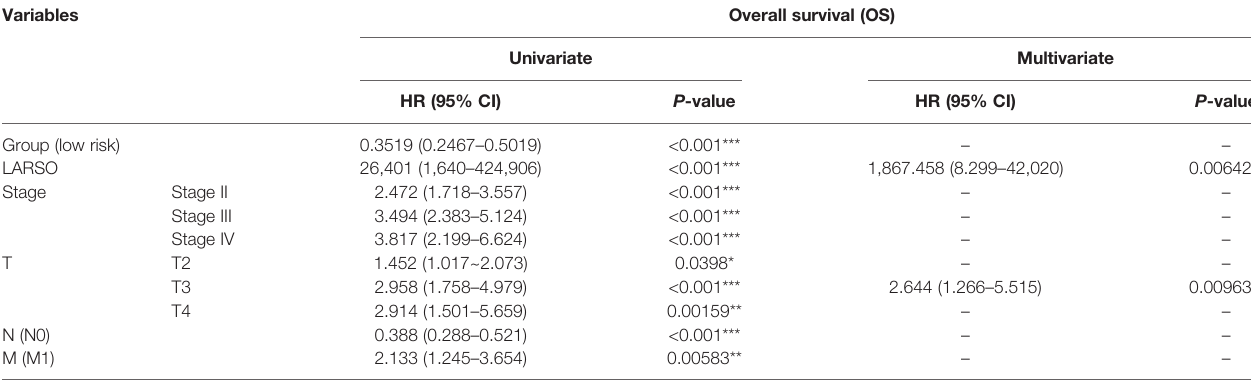
TABLE 2 | Univariate and multivariate analyses for factors in fl uencing overall survival (OS) of lung adenocarcinoma patients in the TCGA database.